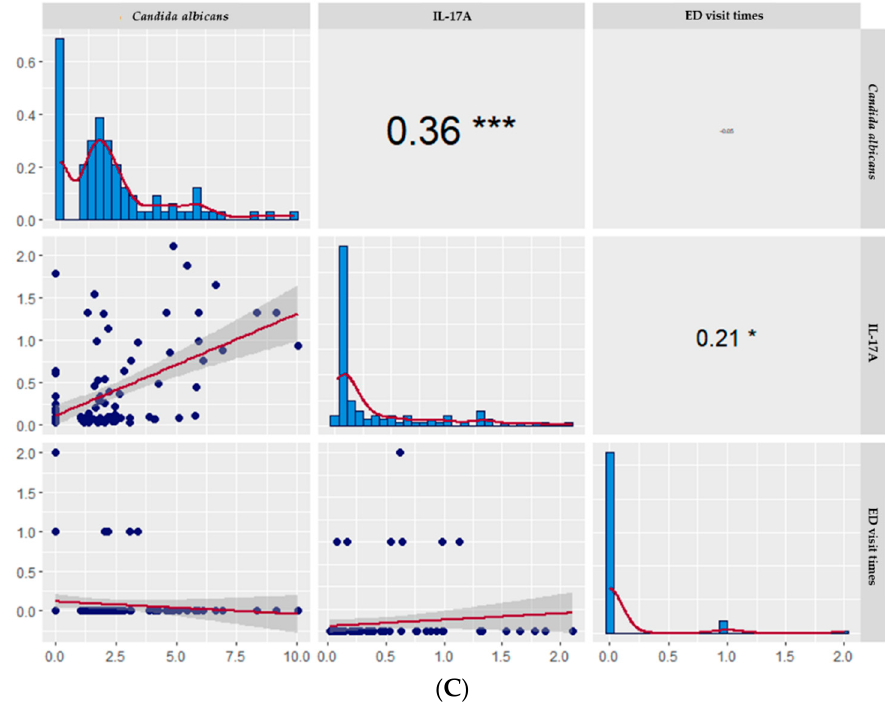
Figure 2. The scatter matrix, histogram, and Spearman rank correlation matrix among ( A ) Botrytis cinerea, ( B ) Saccharomyces, and ( C ) Candida albicans and ED times and IL-17A. * p < 0.05, *** p < 0.001 . 3.4. IL-17A Levels in Asthmatic Patients with and without Fungal Sensitization Grouped by ED